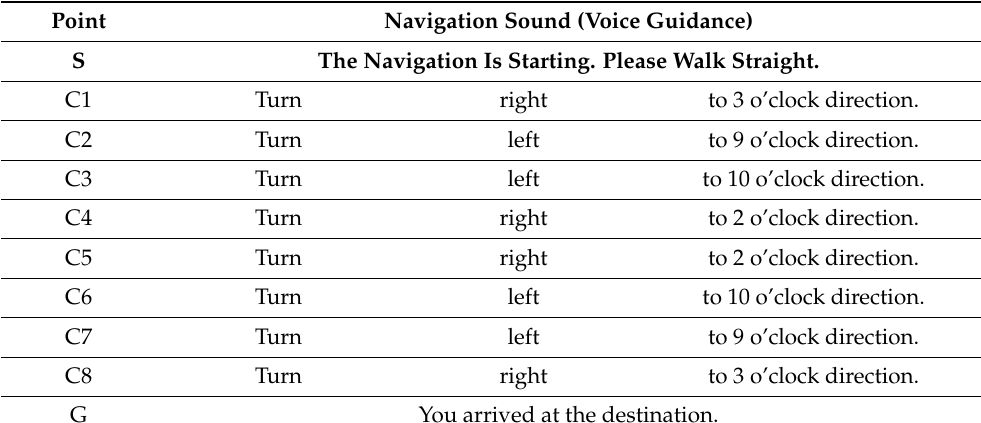
Table 9. Voice information on the direction in which to move at each of the junctions from C1 to C8.